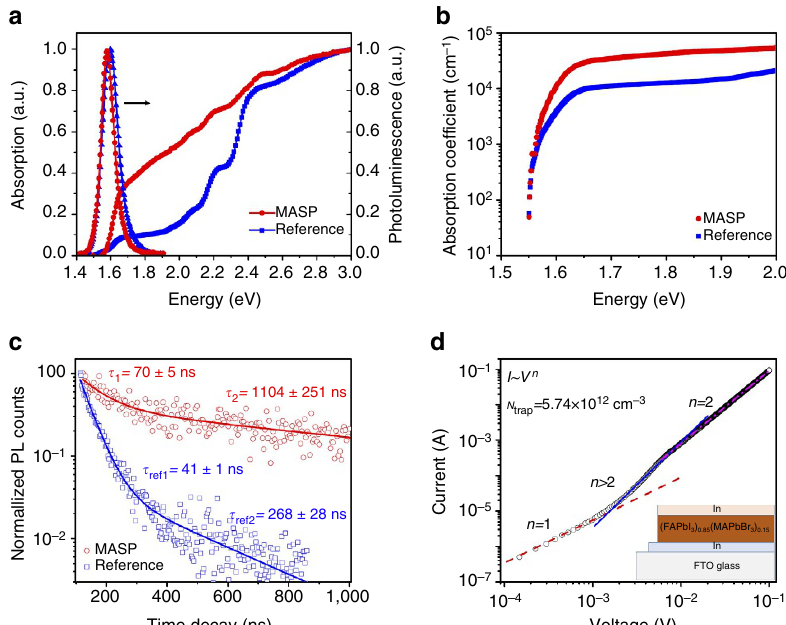
Figure 3 | Optoelectronic properties of FA 0.85 MA 0.15 PbI 2.55 Br 0.45 perovskite films crafted by meniscus-assisted solution printing. ( a ) Ultraviolet– visible (UV–vis) absorption and photoluminescence (PL) spectra of the FA 0.85 MA 0.15 PbI 2.55 Br 0.45 perovskite film crafted by meniscus-assisted solution printing (MASP) and the reference sample prepared by spin coating. ( b ) Urbach tails of the perovskite films prepared by MASP (solid circles) and spin coating (squares), respectively. ( c ) Time-resolved photoluminescence (TRPL) decay traces of the perovskite films prepared by MASP (open circles) and spin coating (open squares), respectively. ( d ) Current–voltage curve of the perovskite film crafted by MASP for space charge limited current (SCLC) analysis. The inset depicts the SCLC